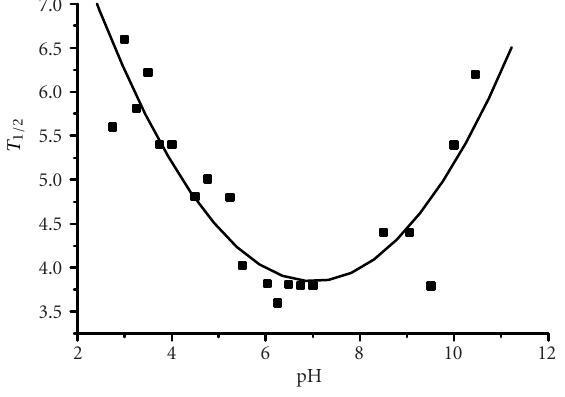
Figure 4: Peak halfwidth of cutinase over the observed pH range. Methods on the surface of cutinase at pH 4 . 0 , 6 . 0 , 8 . 5 , and 10 . 0 (Figure 6). Along the surface of the molecule a network of hydrogen bonds and also salt bridges (Figure 7), provides a possible explanation for the rise of T m found around pH 6 . 0